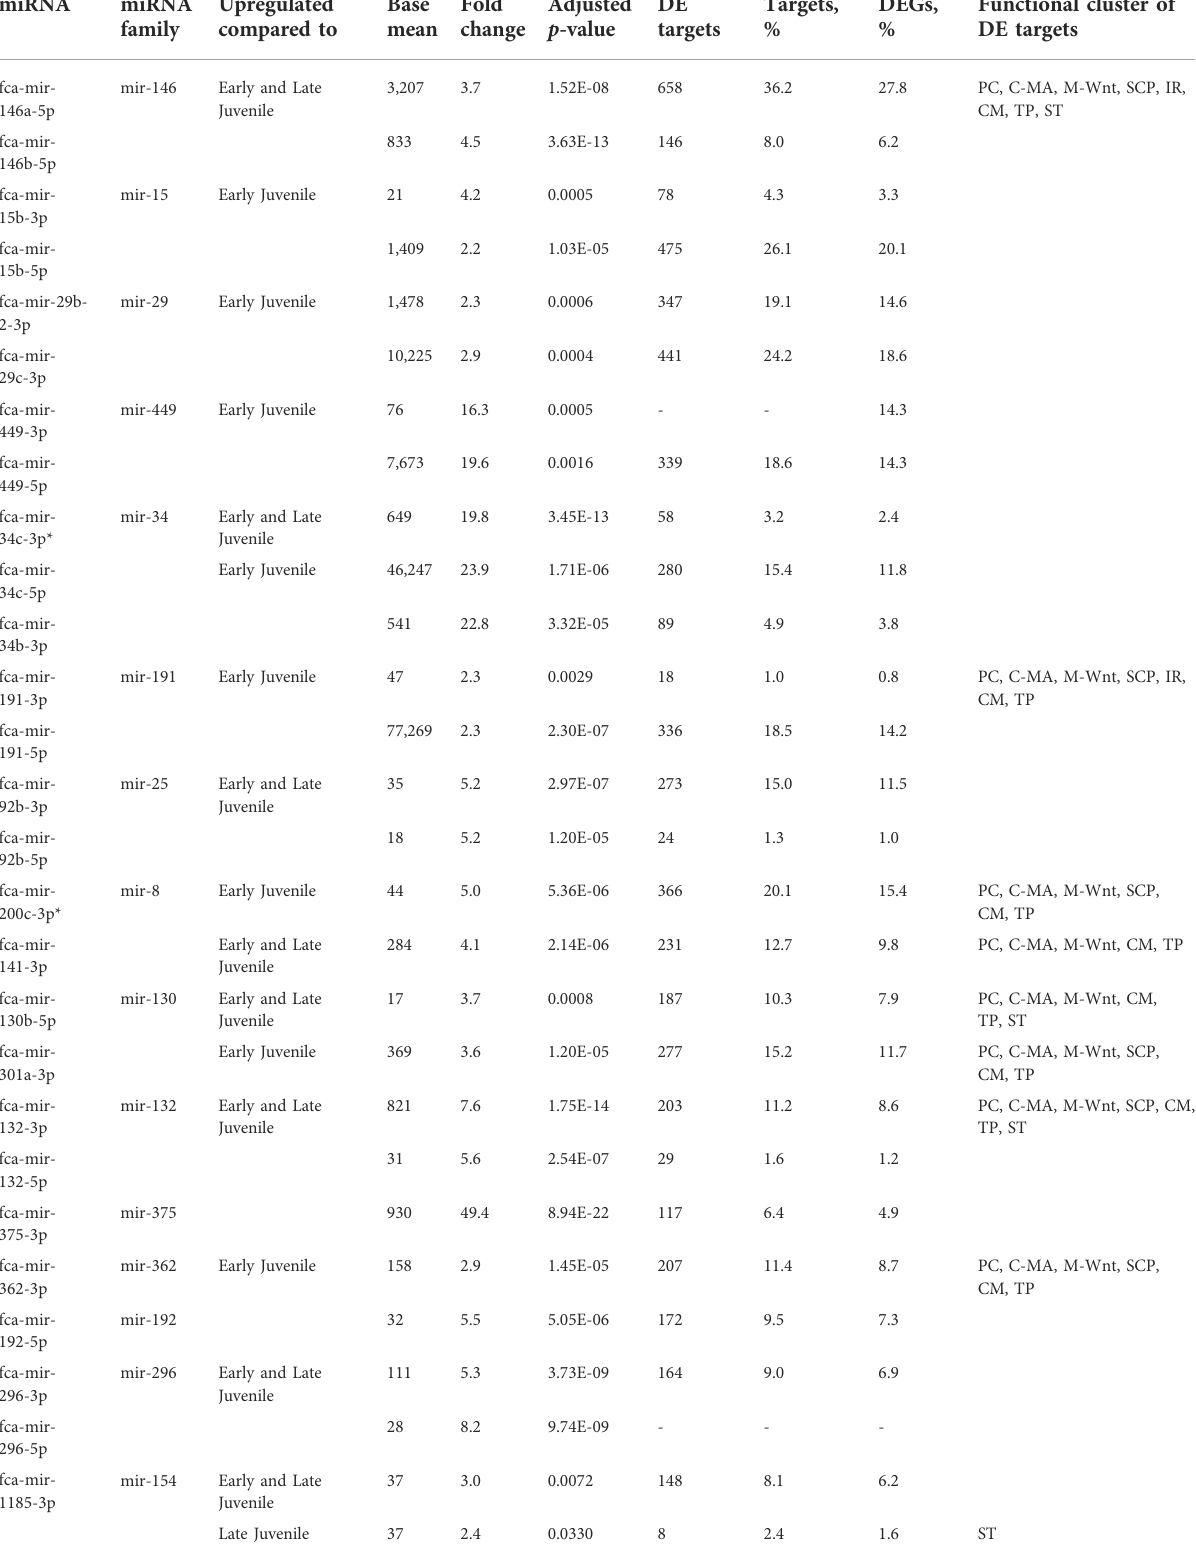
TABLE 1 Impact of upregulated miRNAs on downregulated mRNA in Adult compared to Early and Late Juvenile testis. miRNA miRNA Upregulated family compared to